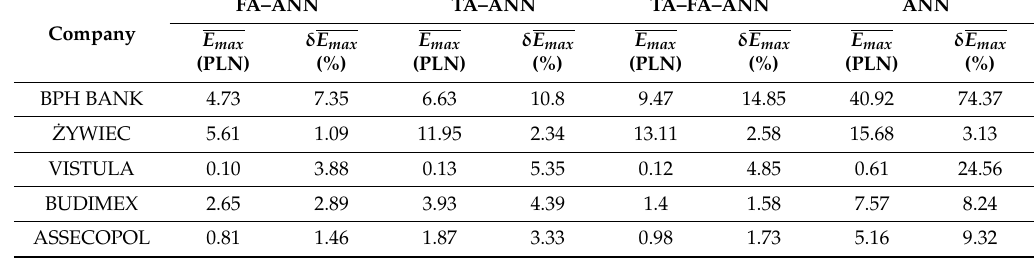
Figure 6. Comparison of E max values per month between all ANN-based models in a period of one year (2010) for ŻYWIEC SA.